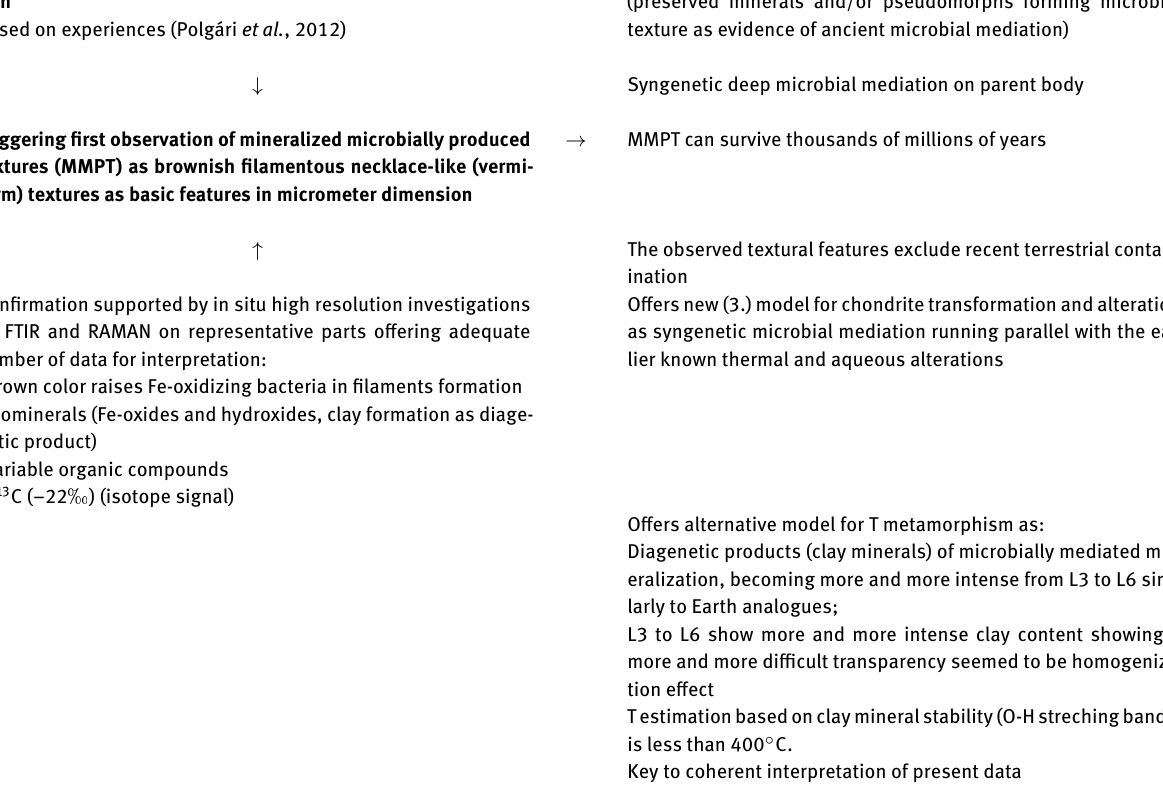
Table 5. Summary of hierarchy of the novel results and interpretations. Initial condition: Detailed geochemical and mineralogical studies for decades without coherent interpretation for UOC over thermal metamorphism and aqueous metasomatism Suggested reason: missing of textural study on adequate magnification by adequate method and interpretation based on